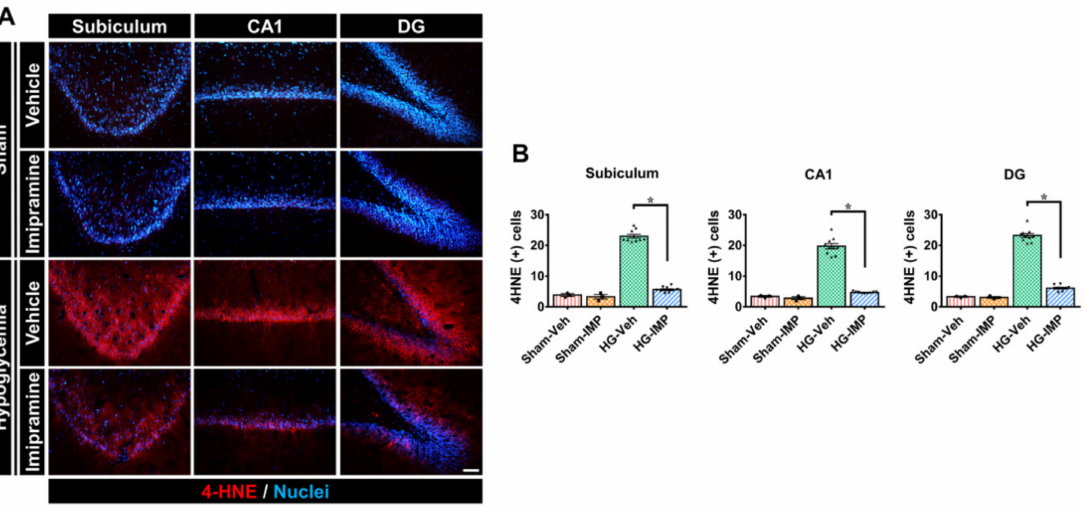
Figure 3. Administration of imipramine reduced oxidative stress after hypoglycemia. Neuronal oxidative stress was detected by 4-hydroxy-2-nonenal (4HNE) staining in the hippocampus: ( A ) sham- operated groups rarely presented the 4HNE signal in the hippocampus. While hypoglycemia caused oxidative stress significantly, imipramine decreased oxidative stress in all three regions of the hip- pocampus. Scale bar = 50 µ m. ( B ) Quantification of 4HNE fluorescence intensity in the hippocampus. The fluorescence indicates a significant gap between the vehicle- and imipramine-treated groups. Data are the mean ± SEM; n = 3 for each sham group, n = 9–10 for each hypoglycemia group. Indi- vidual data points ( • = Sham-Veh, (cid:4) = Sham-IMP, (cid:78) = HG-Veh, (cid:72) = HG-IMP). * Significantly different from the vehicle-treated group at p < 0.05.